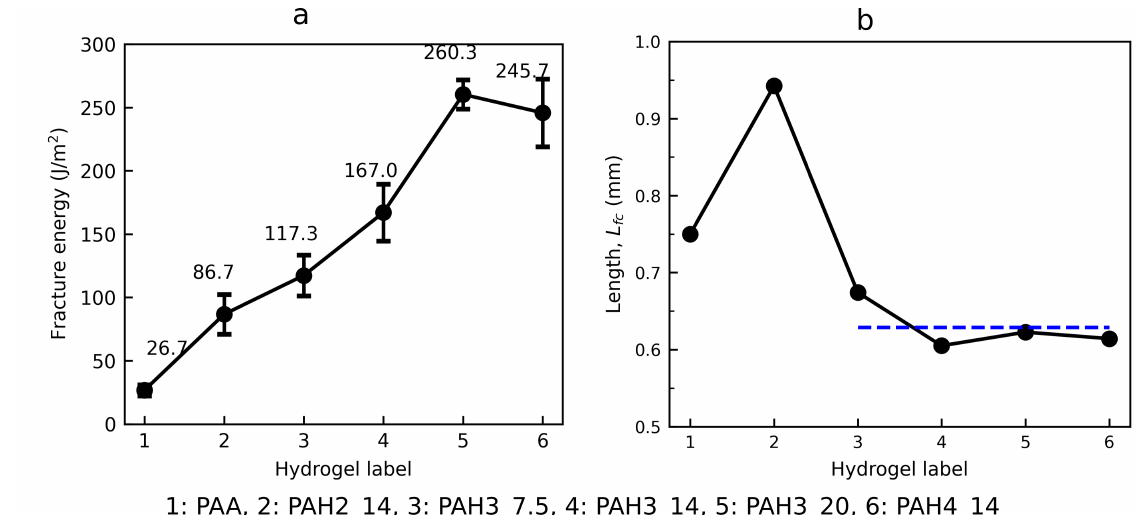
Figure 7. Varying fracture energy ( a ), and fractocohesive length ( b ), L fc , as a function of hydrogel type. The hydrogel labels ranging from 1 to 6 represent PAA, PAH2_14, PAH3_7.5, PAH3_14, PAH3_20, and PAH4_14, in order. The blue dashed horizontal line in plot ( b ) shows the mean value of L fc among the hydrogels, labelled from 3 to 6. Error bars show the SD; sample size, n = 3 per experiment.